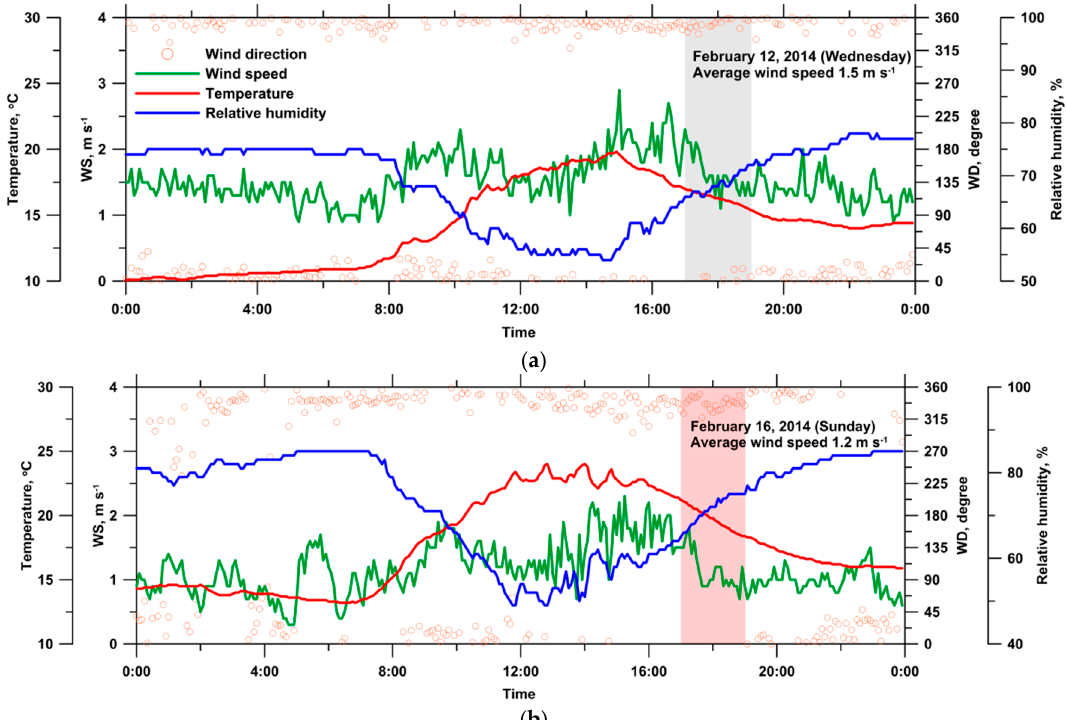
Figure 3. Diurnal variations of meteorological conditions at the monitoring site on ( a ) the reference day; and ( b ) the event day.